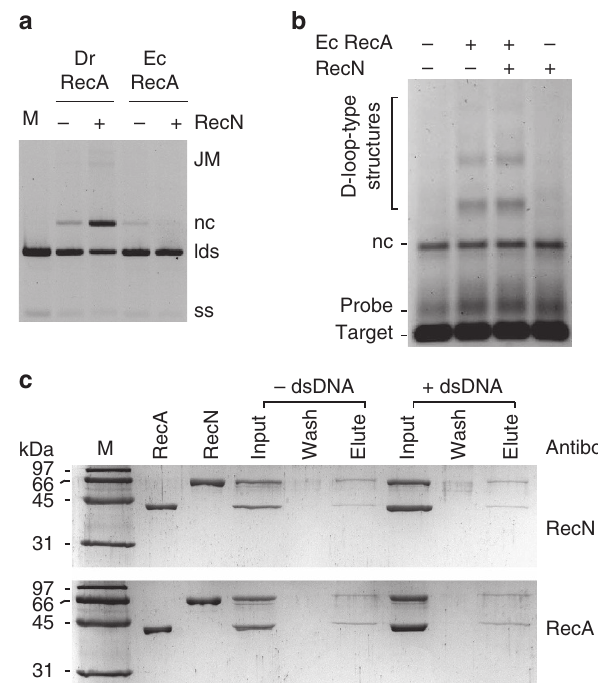
Figure 3 | RecA and RecN proteins interact. ( a ) The D. radiodurans (Dr) or E. coli (Ec) RecA protein (0.4 m M) was incubated with 1 m M circular ssDNA (ss) for 10min. ATP (3mM), RecN (0.5 m M, where indicated) and 0.08 m M SSB were added and incubated for an additional 10min. The reaction was initiated by the addition of 2 m M homologous duplex DNA (lds). All reactions were incubated for 45min after lds addition except for M. The reaction of the control lane (M) was immediately stopped after lds addition. DNA was recovered from the reaction before gel electrophoresis (see Methods). This experiment was repeated three times with similar results. (cid:2) DrRecN protein. Quantification of RecN stimulation of DrRecA DNA (6.7 m M) was incubated with 20 m M probe DNA for 10min. ATP (3mM) Fig. 2 for target and probe DNA description. This experiment was repeated three times with no measurable difference between þ and – RecN conditions. ( c ) Purified D. radiodurans RecA (38kDA) and RecN (60kDa) proteins co-elute, in the presence ( þ dsDNA) or absence ( (cid:2) dsDNA) of linear duplex DNA, from a RecN antibody-coupled resin (top) or from a RecA antibody-coupled resin (bottom). Lane M indicates a protein size marker. The input lanes contain an 8 m l load of a mixture of 0.12 m g RecN per m l and 0.08 m g RecA per m l. Excess protein complex was removed during the early wash steps, and 8 m l of the final 50 m l wash and 8 m l of the 50 m l elution were loaded directly onto the gel. Fig. 2b,c). RecN does not promote DNA pairing in the absence of RecA (see Fig. 3b below). Interestingly, the RecN stimulation of RecA-mediated D-loop formation is not observed when a RecN ATPase-deficient mutant (RecN K67A) is used in the reaction (lane 6, Fig. 2b). This indicates that RecN ATP hydrolysis is required for the stimulation of RecA under these conditions. The requirement for ATP hydrolysis will be explored further below.